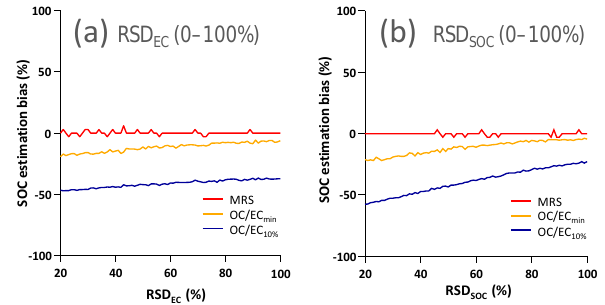
Figure 4. Bias of SOC determination as a function of (a) RSD EC ; (b) RSD SOC . Different representation of (OC / EC) pri include MRS, OC / EC min and OC / EC 10 % . Fixed input parameters: n = 8000, EC = 2 ± 1µgCm − 3 , (OC / EC) pri = 0 . 5, POC = 1